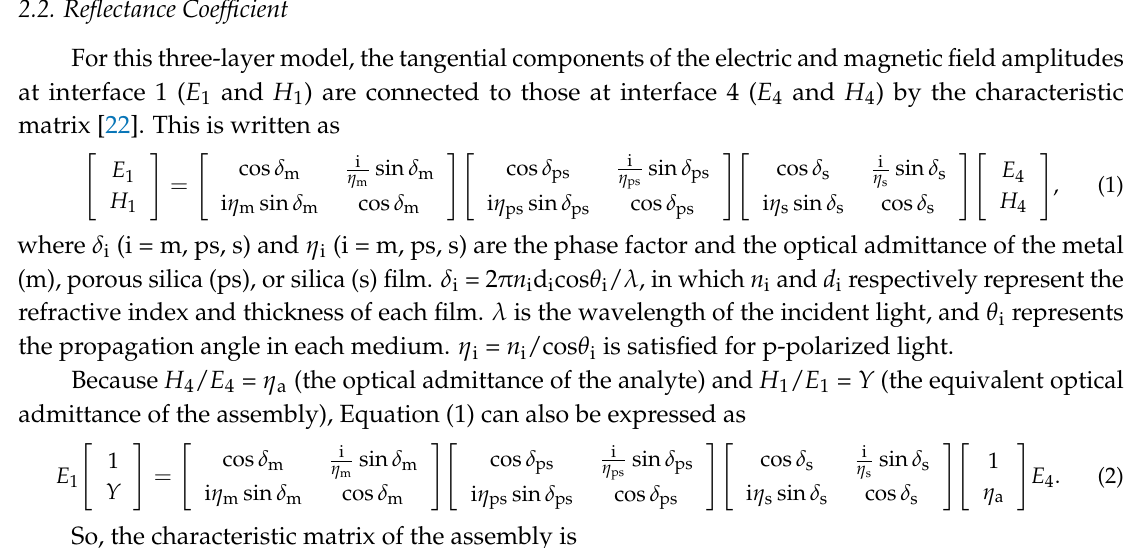
Figure 2. Three-layer model of the proposed SPR sensor.